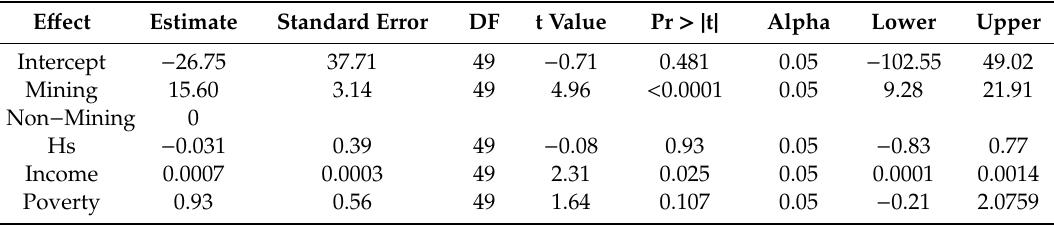
Table 2. ANCOVA Results. E ff ects of county MTM status after controlling for socioeconomic factors 2005–2015.